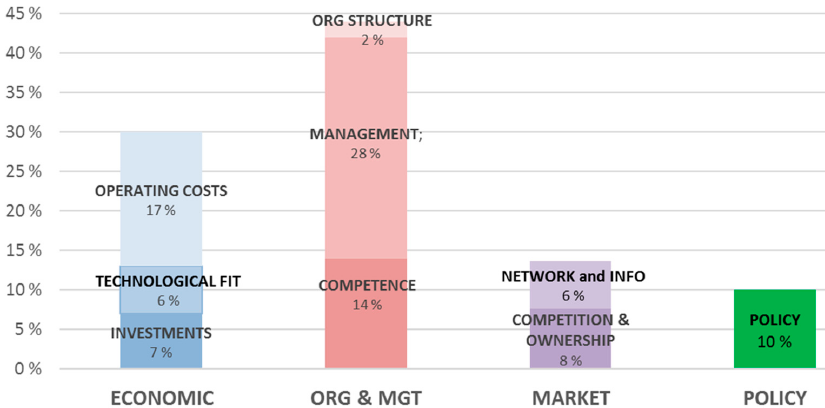
Figure 6. Categorization of drivers to energy efficiency.